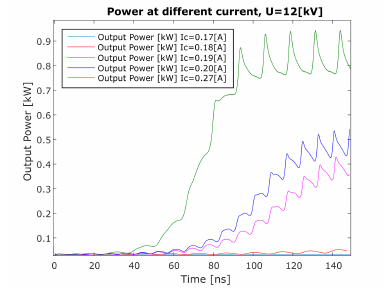
Figure 6. Gyrotron output power for different current